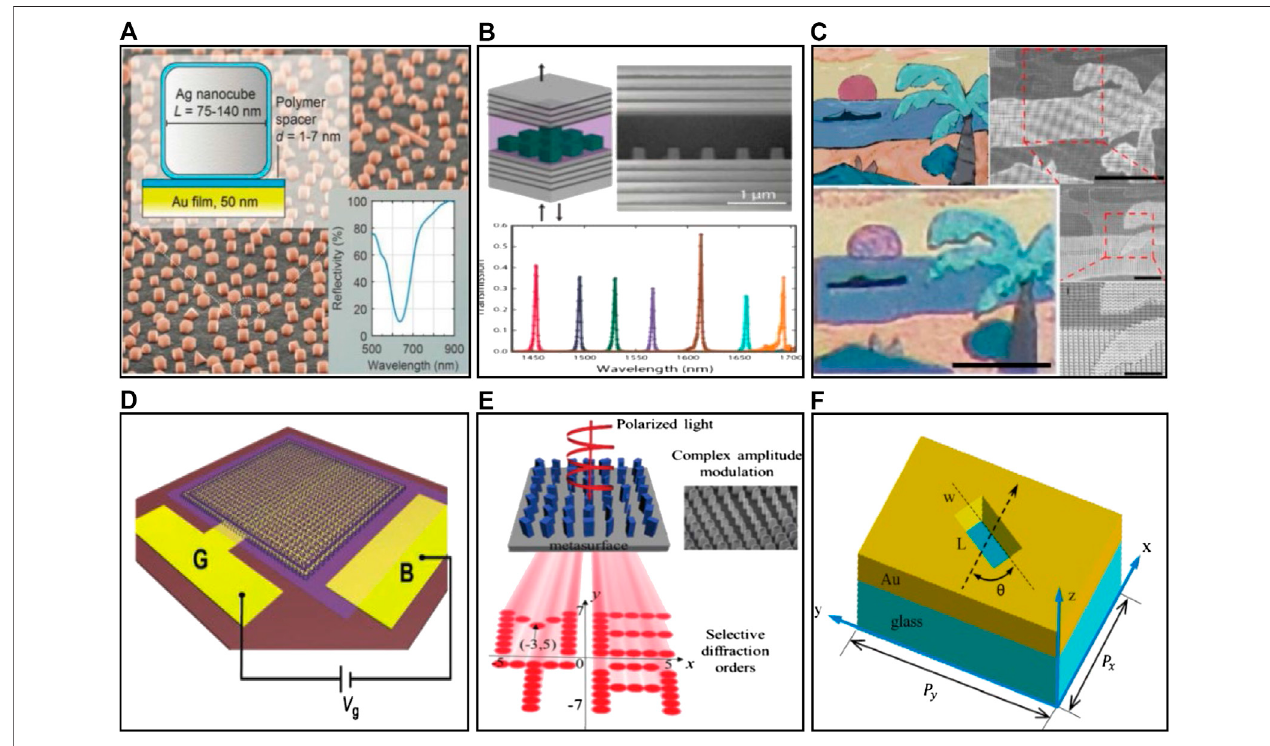
FIGURE 1 | Amplitude-modulated metasurface design and its typical applications. (A) Broadband absorber [63], (B) spatial fi lter [64], (C) color printing [66], (D) graphene metasurfaces [67], (E) selective diffraction with a dielectric metasurface [68], and (F) a single nanoaperture in one period [69].